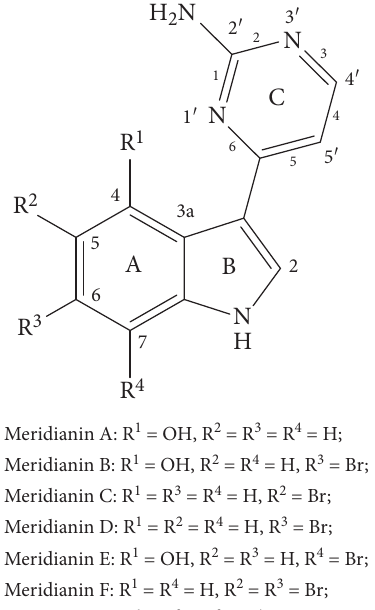
Figure 1: Structure, nomenclature of meridianins